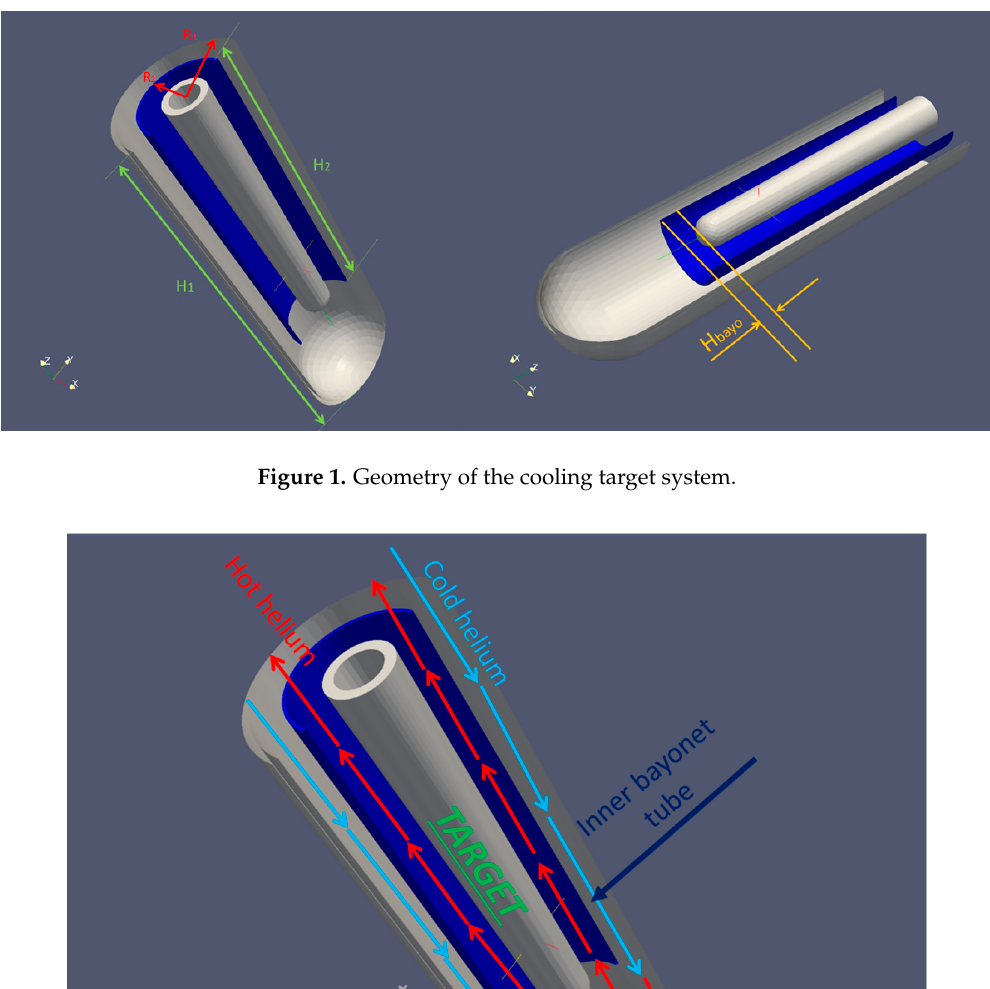
Figure 2. Target Bayonet tube scheme of operation.